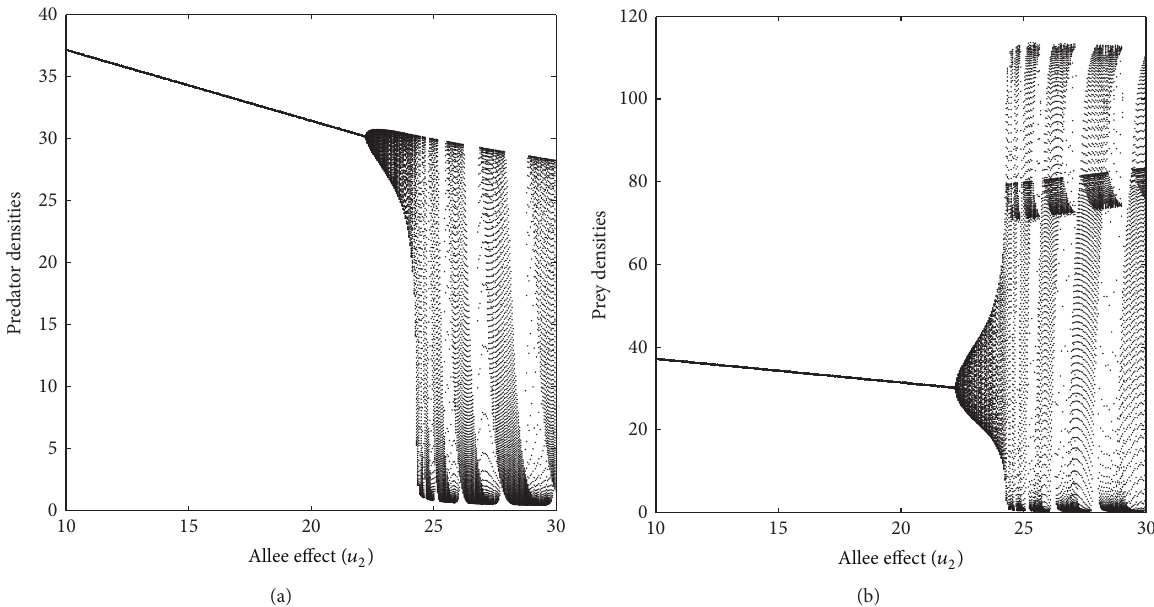
Figure 6: Bifurcation diagrams of predator and prey densities in model (24) with the initial conditions 𝑥 0 = 30 , 𝑦 0 = 20 and the parameter values 𝑟 = 3 , 𝛼 = 0.04 , 𝛽 = 0.04 , and 𝐾 = 100